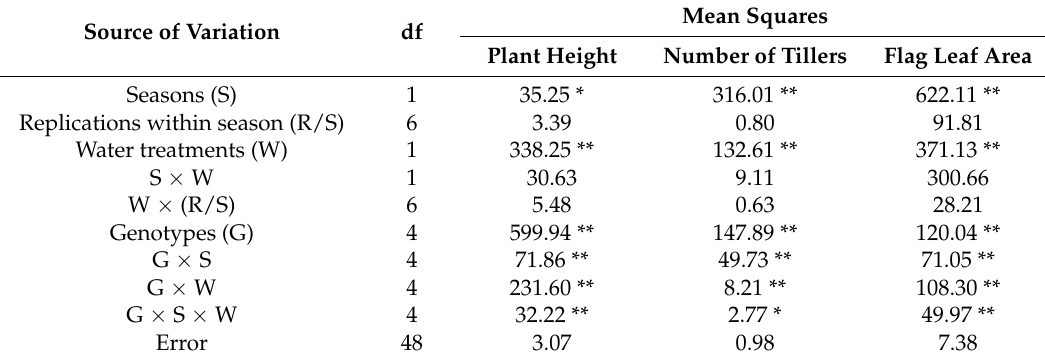
Table 1. Combined analysis of variance (ANOVA) over seasons for plant growth